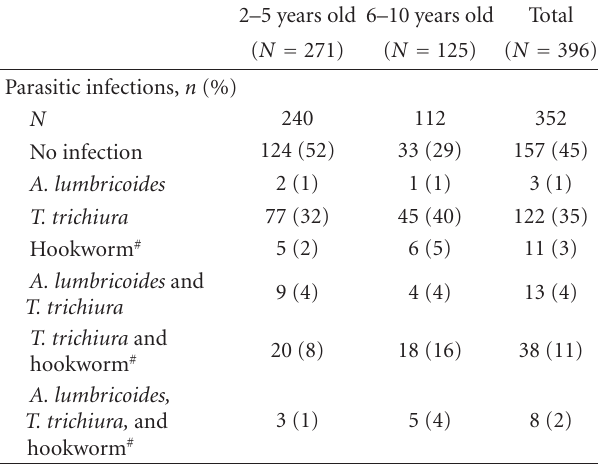
Table 2: Prevalence of soil-transmitted helminth infections based on the baseline egg counts evaluation.